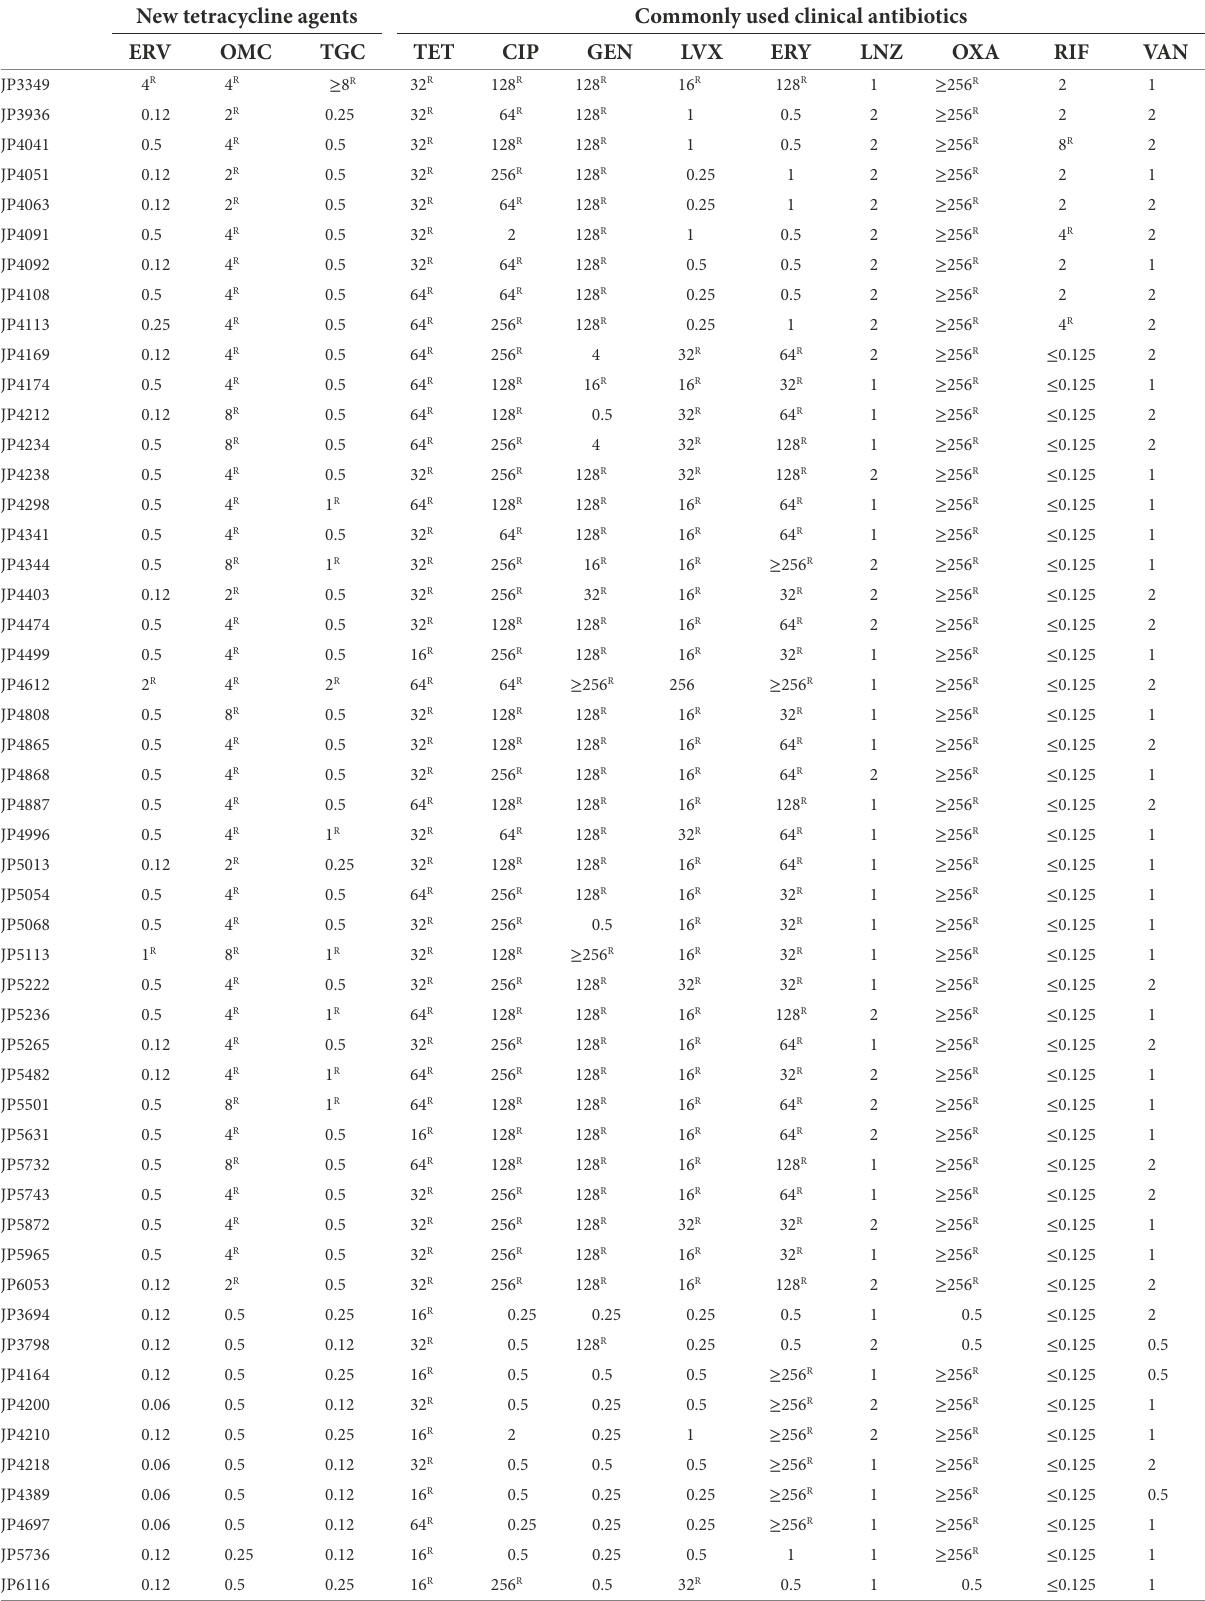
TABLE 3 Characteristics of the resistance spectrum of tetracyclines-resistant and-susceptible Staphylococcus aureus isolates. Isolates MIC ( μ g/mL) Commonly used clinical